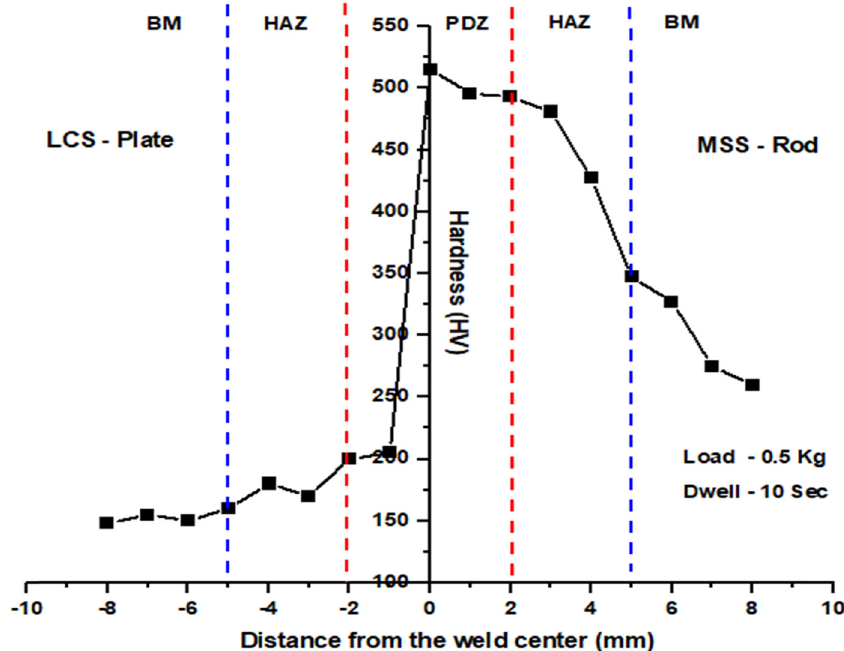
Figure 14: Microhardness distribution of dissimilar rod - to - plate joint cross -